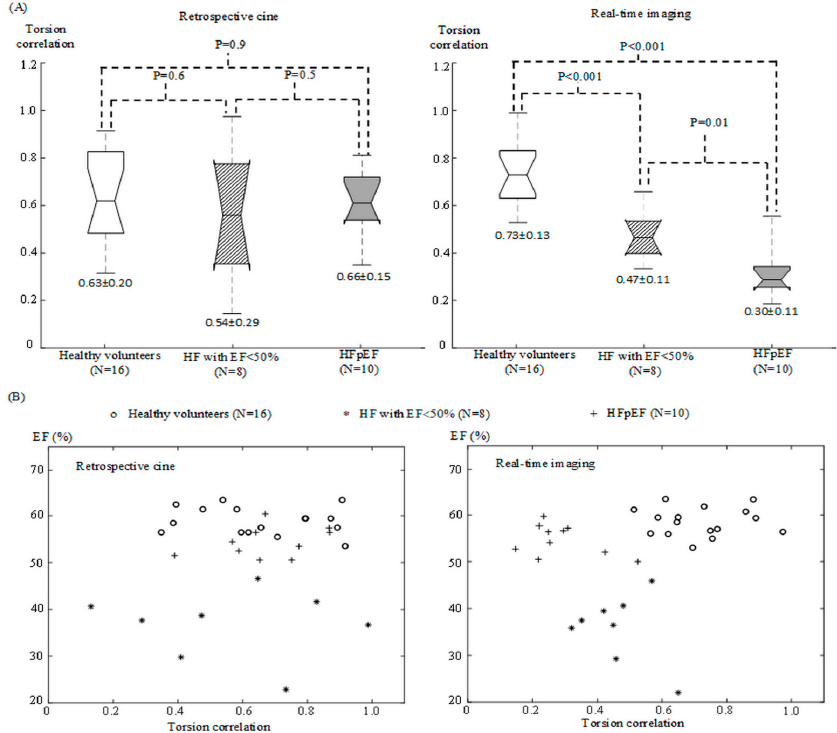
Figure 6. Correlation analysis with retrospective cine and real-time images from 16 healthy volunteers, and 18 HF patients. ( A ) Box plots for the measurements of torsion correlation in the healthy volunteers (N = 16), HF patients with EF < 50% (N = 8) and patients with HFpEF (N = 10). The numbers above the boxes provide P values from one-way ANOVA statistics and those below the boxes are the mean and standard deviation in each subject group. ( B ) Scatter plots of EF against torsion correlation from retrospective cine and real-time images. The patients with HFpEF and the healthy volunteers were differentiated in the plots from real-time images while they were mixed in those from retrospective cine images.